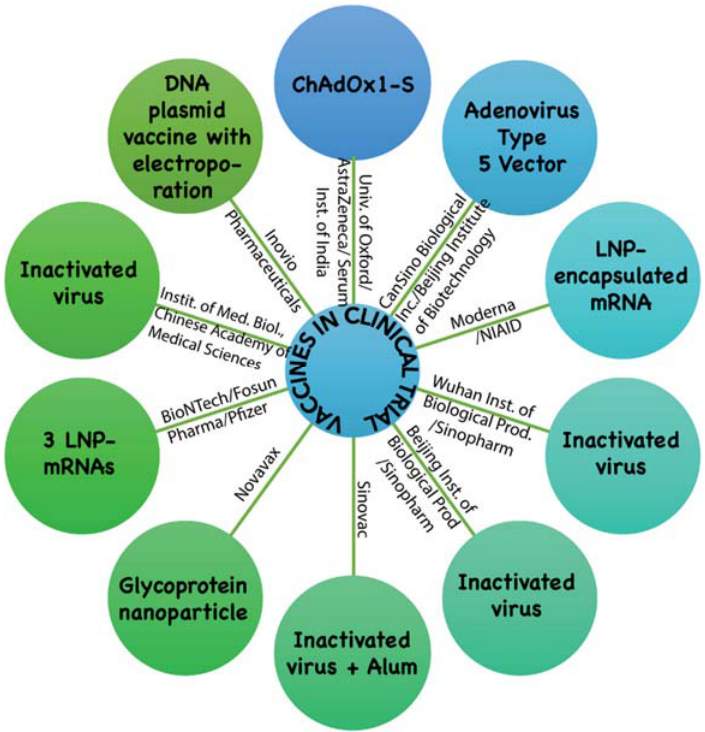
Figure 2. Ten vaccine candidates are in clinical trial, as shown in the figure. Information was